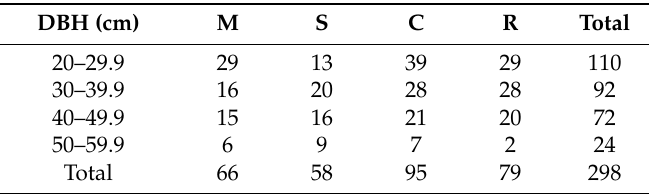
Table 1. Number of trees that were sampled at the six sites by diameter class at breast height (DBH, 1.3 m) and tree vigor class DBH (cm) M S C R Total 20–29.9 29